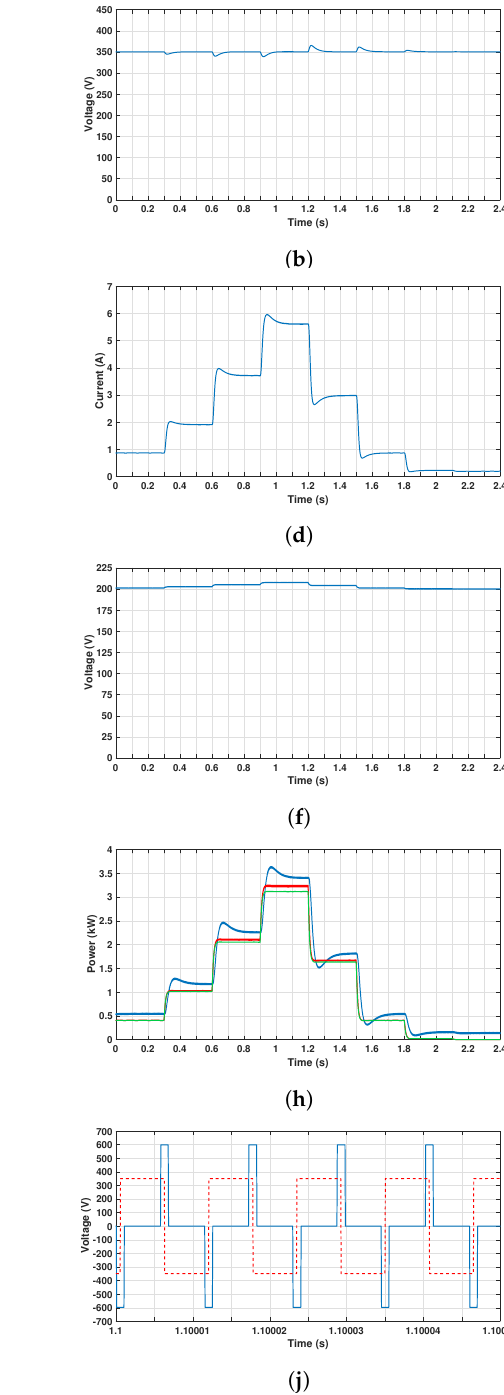
= 350 V. Time responses of: ( a ) the Figure 14. Results obtained for the G2V mode when k = 0.7 k n and v ∗ DC 2 battery current i b (blue) and the reference i ∗ (red); ( b ) the DC voltage v DC 2 ; ( c ) the phase-shift angle α ; b ( d ) the current i in ; ( e ) the current i 0 ; ( f ) the voltage of the battery v b ; ( g ) the DC voltage v DC 1 ; ( h ) the grid power P g (blue), the power at the input of the DC–DC converter P dc (red) and the battery power P b (green); ( i ) currents of the compensated magnetic coupler i 1 (blue), and i 2 (red); ( j ) voltages across the compensated magnetic coupler v 1 (blue), and v 2